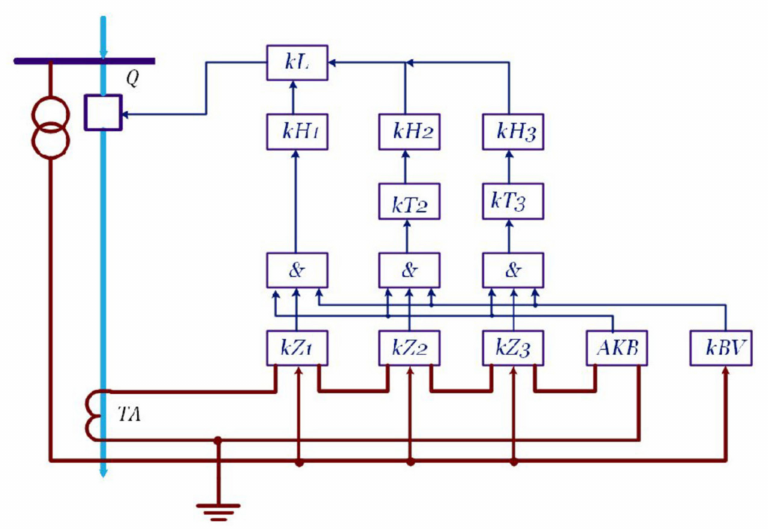
Figure 1. Block diagram of distance protection: Q—switch; TA—current transformer; kZ 1 , kZ 2 , kZ 3 —resistance relay; AKB—swing blocking device; KBV—blocking device against voltage circuits violation; &—logical multiplication body; kT1, kT2—time relay; kH 1 , kH 2 , kH 3 - indicator relays, kL—intermediate